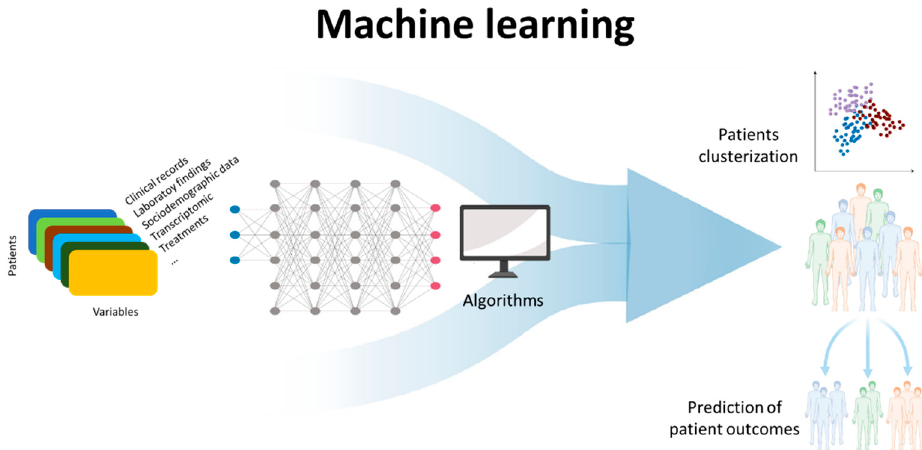
Figure 5. Schematic representation of a machine-learning process.